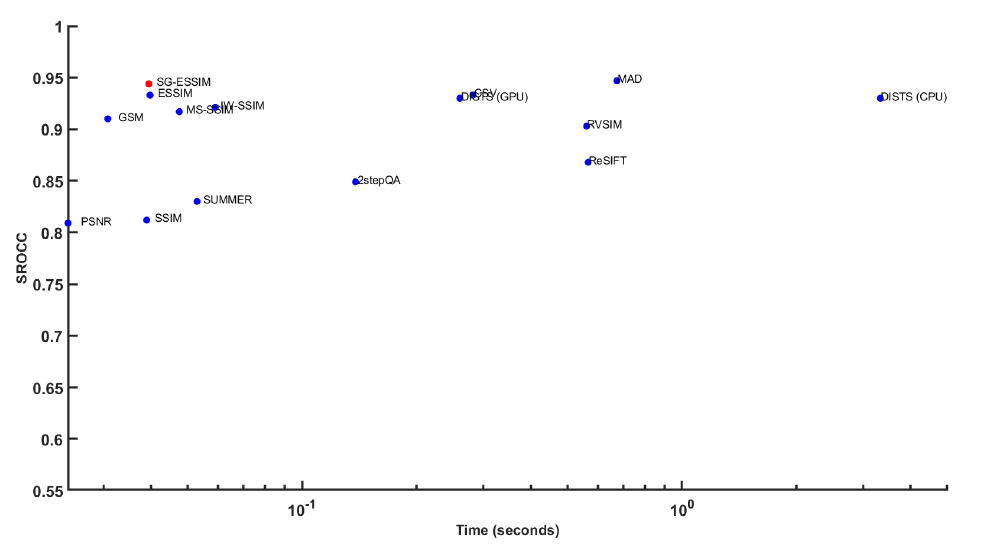
Figure 4. Execution time (logarithmic scale) versus SROCC measured on CSIQ